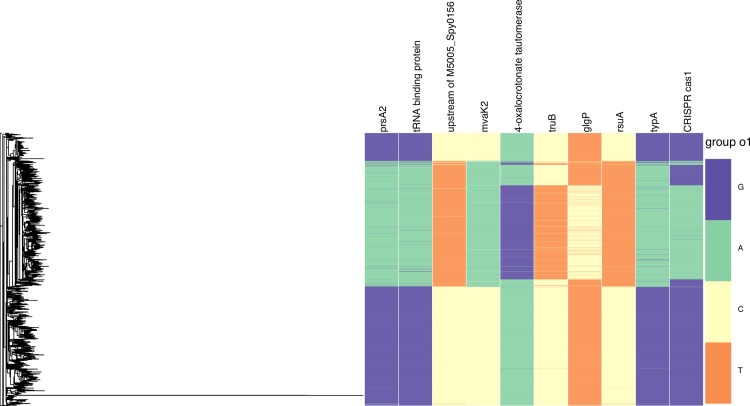
Phylogeny of the M1 lineage and the distribution of minor/major alleles in the SNP loci involved in the 20 most highly ranked significant couplings.